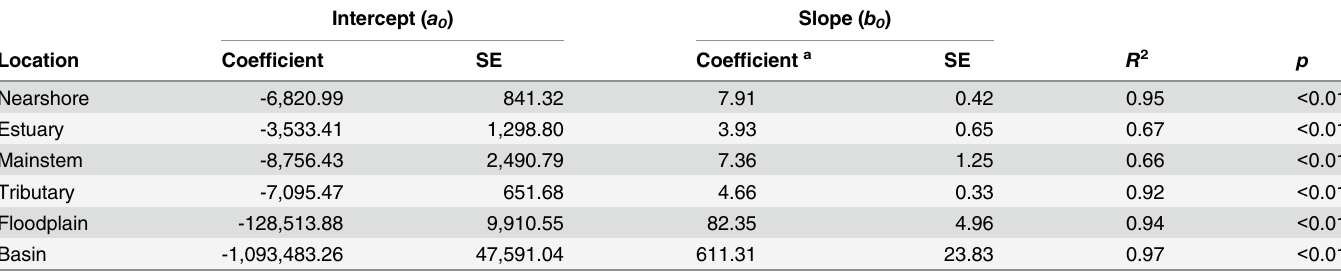
Table 2. Simple Regression Analysis Results: Puget Sound Scale.